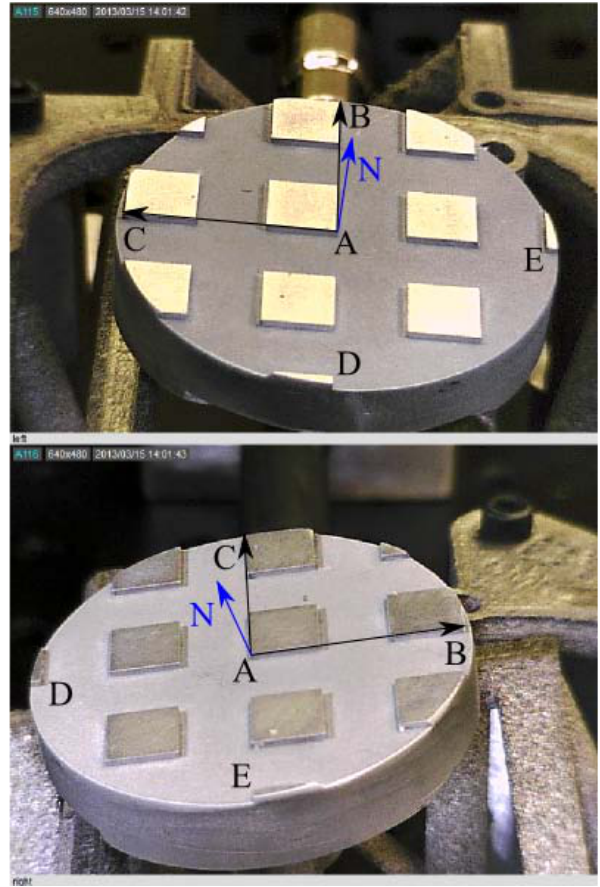
Figure 9. Points A, B, C, D, and E with vector N used for measure- ment of φ and ψ on the titanium prototype.